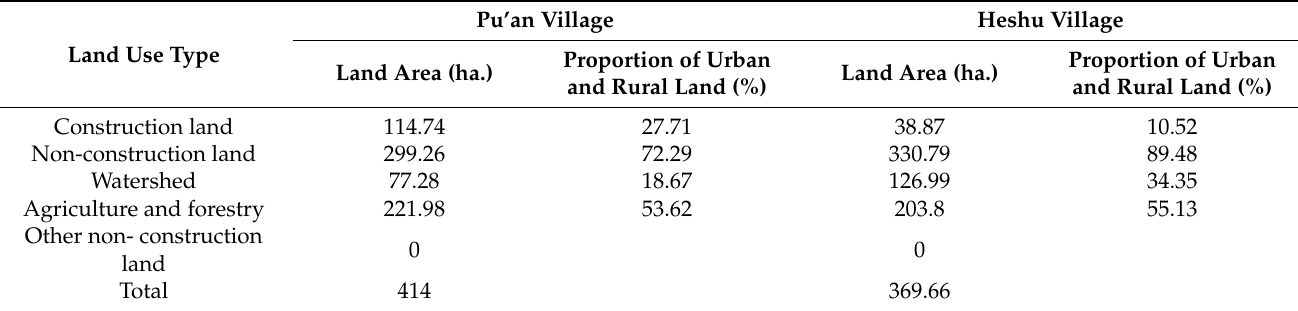
Table 1. Land use in Heshu village and Pu’an village in